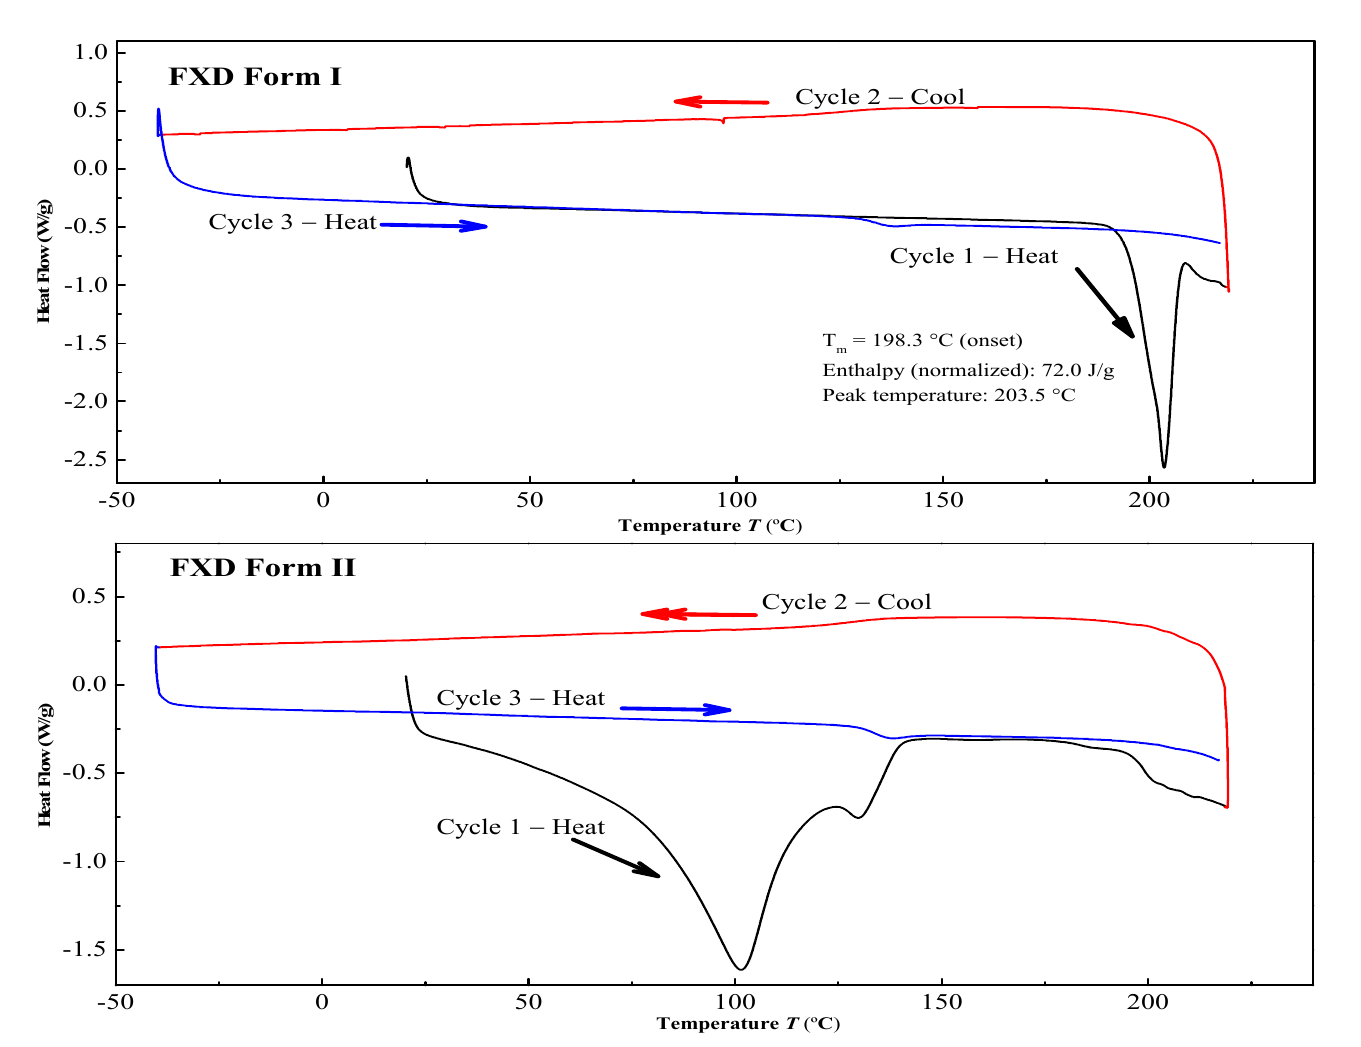
Figure 2. Differential scanning calorimetry (DSC) curves of the FXD solid forms.